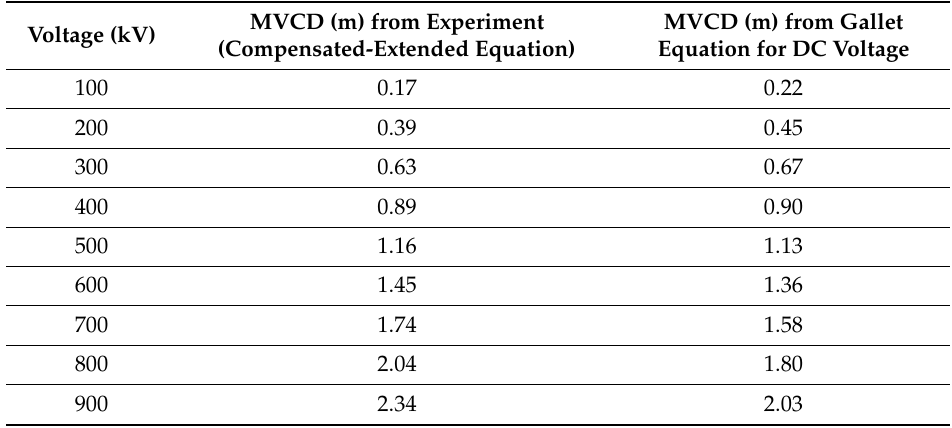
Table 4. Experimental (compensated-extended) MVCD values vs. MVCD values from the Gallet equation at different